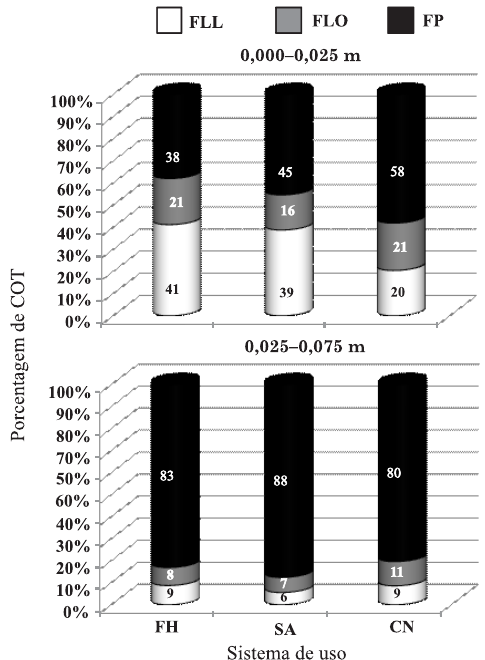
Figura 2. Proporção de carbono da fração leve livre (FLL), fração leve oclusa (FLO) e fração pesada (FP) de um Argissolo Vermelho submetido a diferentes sistemas de uso e camadas. FH: Floresta homogênea de eucalipto; SA: Sistema agrossilvipastoril na entrelinha; e CN: Campo nativo.